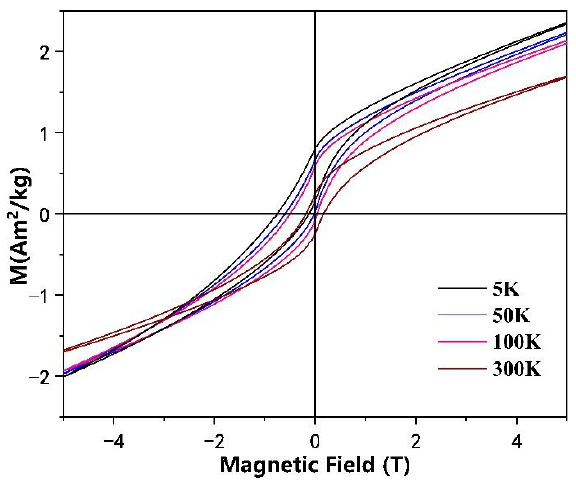
Figure 7. Magnetic hysteresis loops of the severely deformed Mn 4 N.